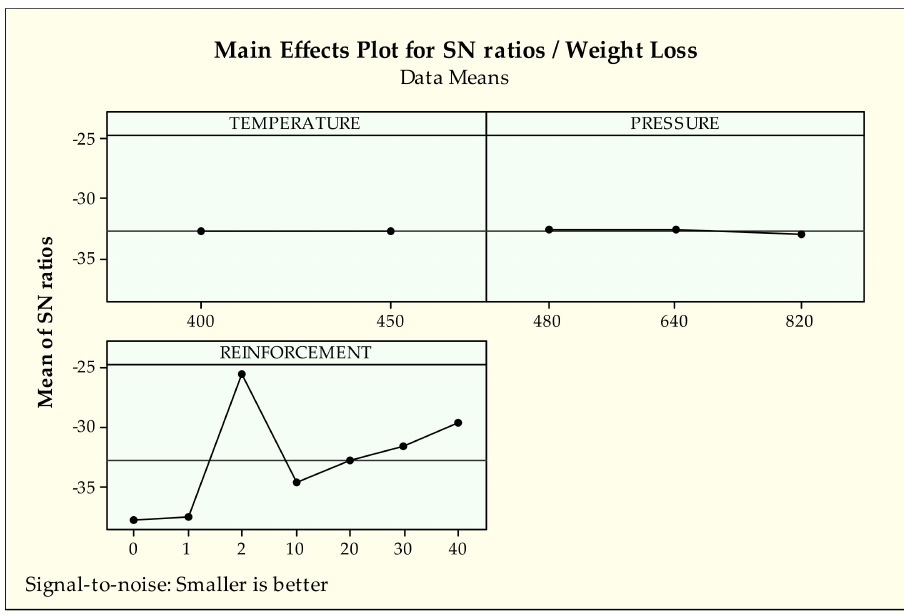
Figure 8. S/N ratios of weight